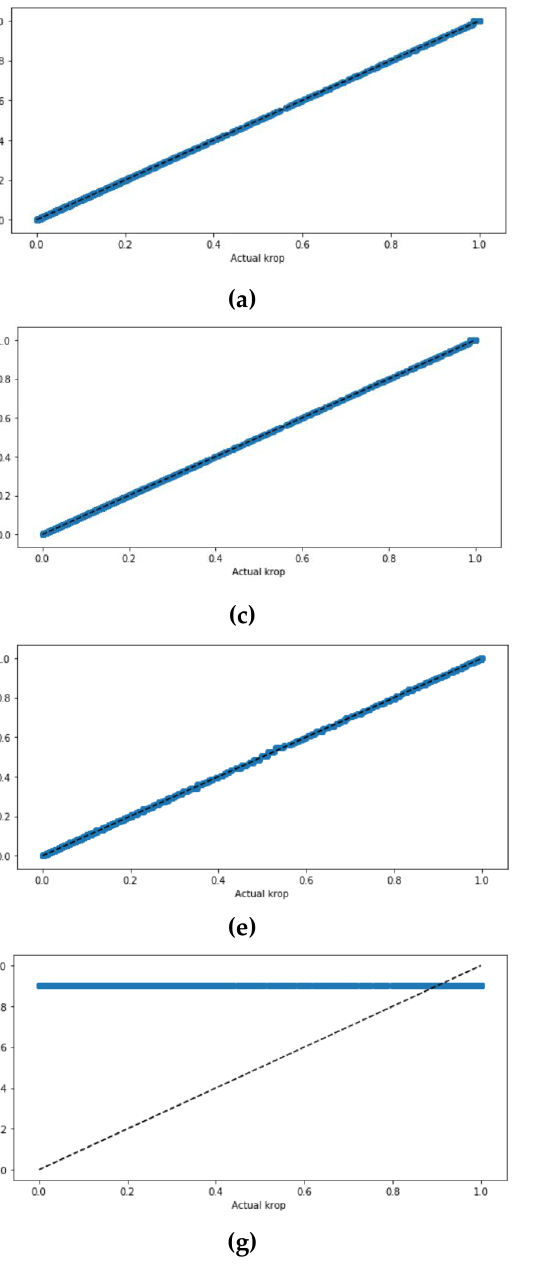
Figure 9. Actual against predicted k rop using different machine learning techniques DT, RF, GBR, and ANN. ( a ) DT without scaling, ( b ) DT with scaling, ( c ) RF without scaling, ( d ) RF with scaling, ( e ) GBR without scaling, ( g ) GBR with scaling, ( f ) ANN without scaling with tanh, ( h ) ANN scaling with tanh. The dashed line represents a full coinciding between actual and predicted data.